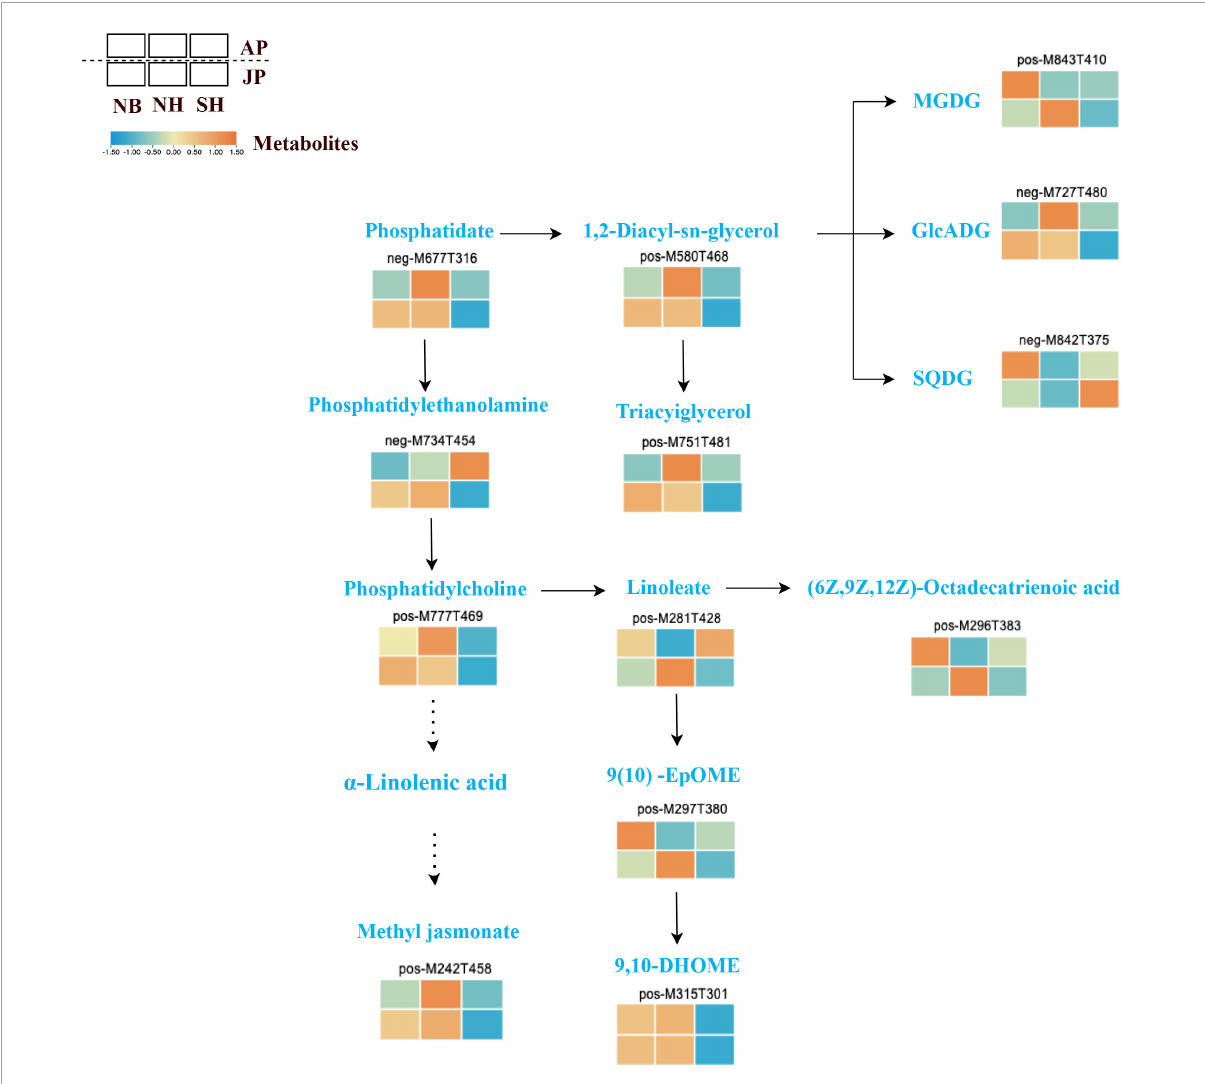
FIGURE6 Different expressions of structural metabolites in lipid metabolism. Red and blue blocks represent upregulation and downregulation of expression,